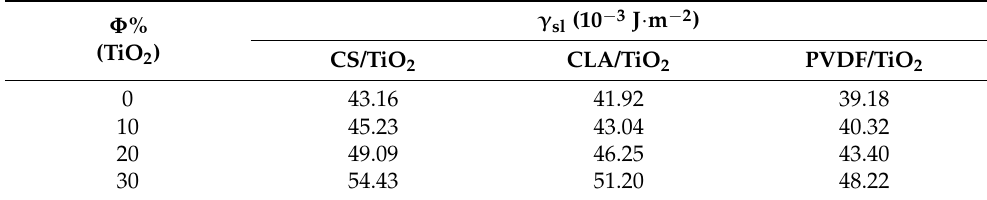
Table 7. Interfacial tension of CS/TiO 2 , CLA/TiO 2 and PVDF/TiO 2 with water as function Φ of TiO 2